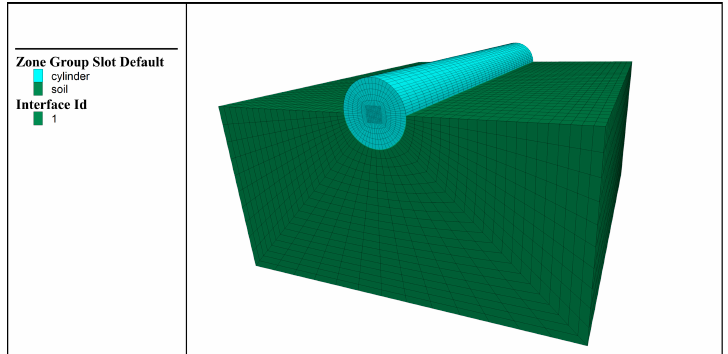
Figure 7. Silty soil and object model. The simulation flowchart is shown in Figure 8.